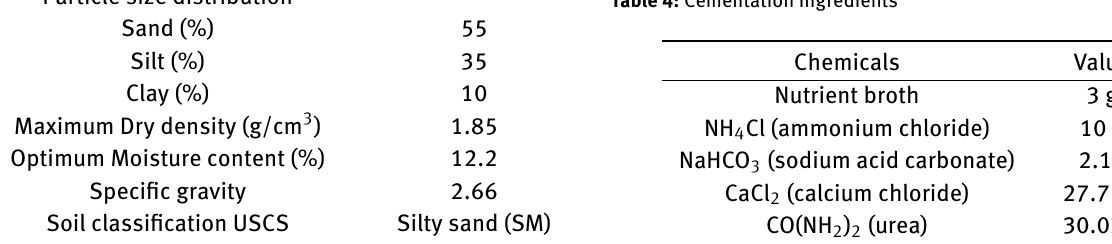
Table 4: Cementation